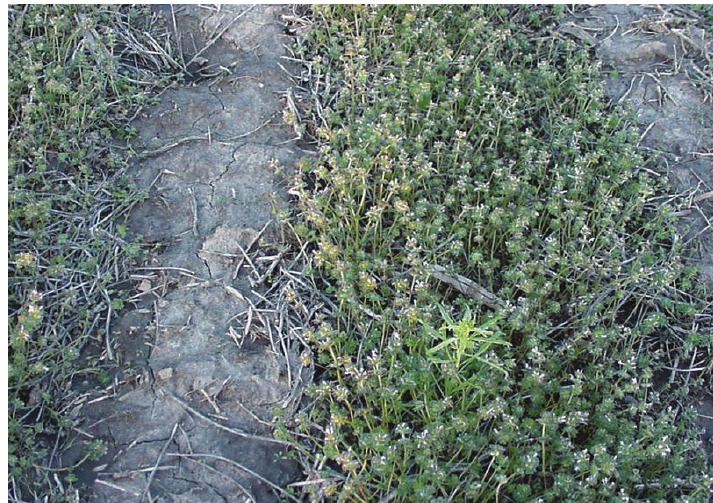
Figure 2: Henbit response to an early preplant strip-tillage (7 April 2008) treatment on 24 April